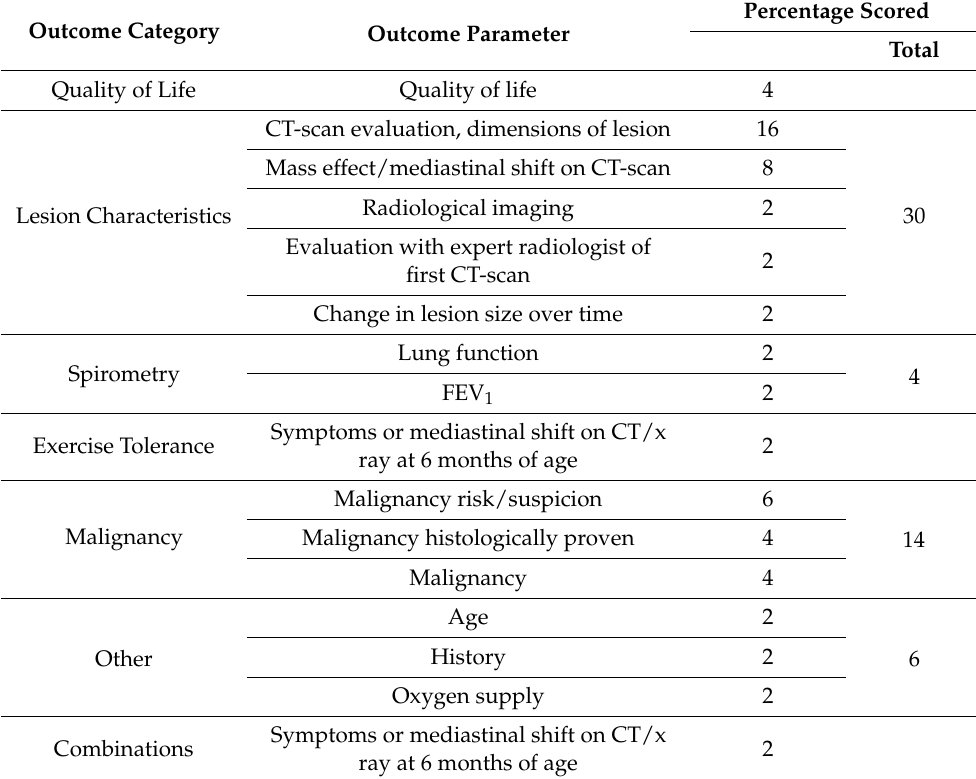
Table 4. Cont. Outcome